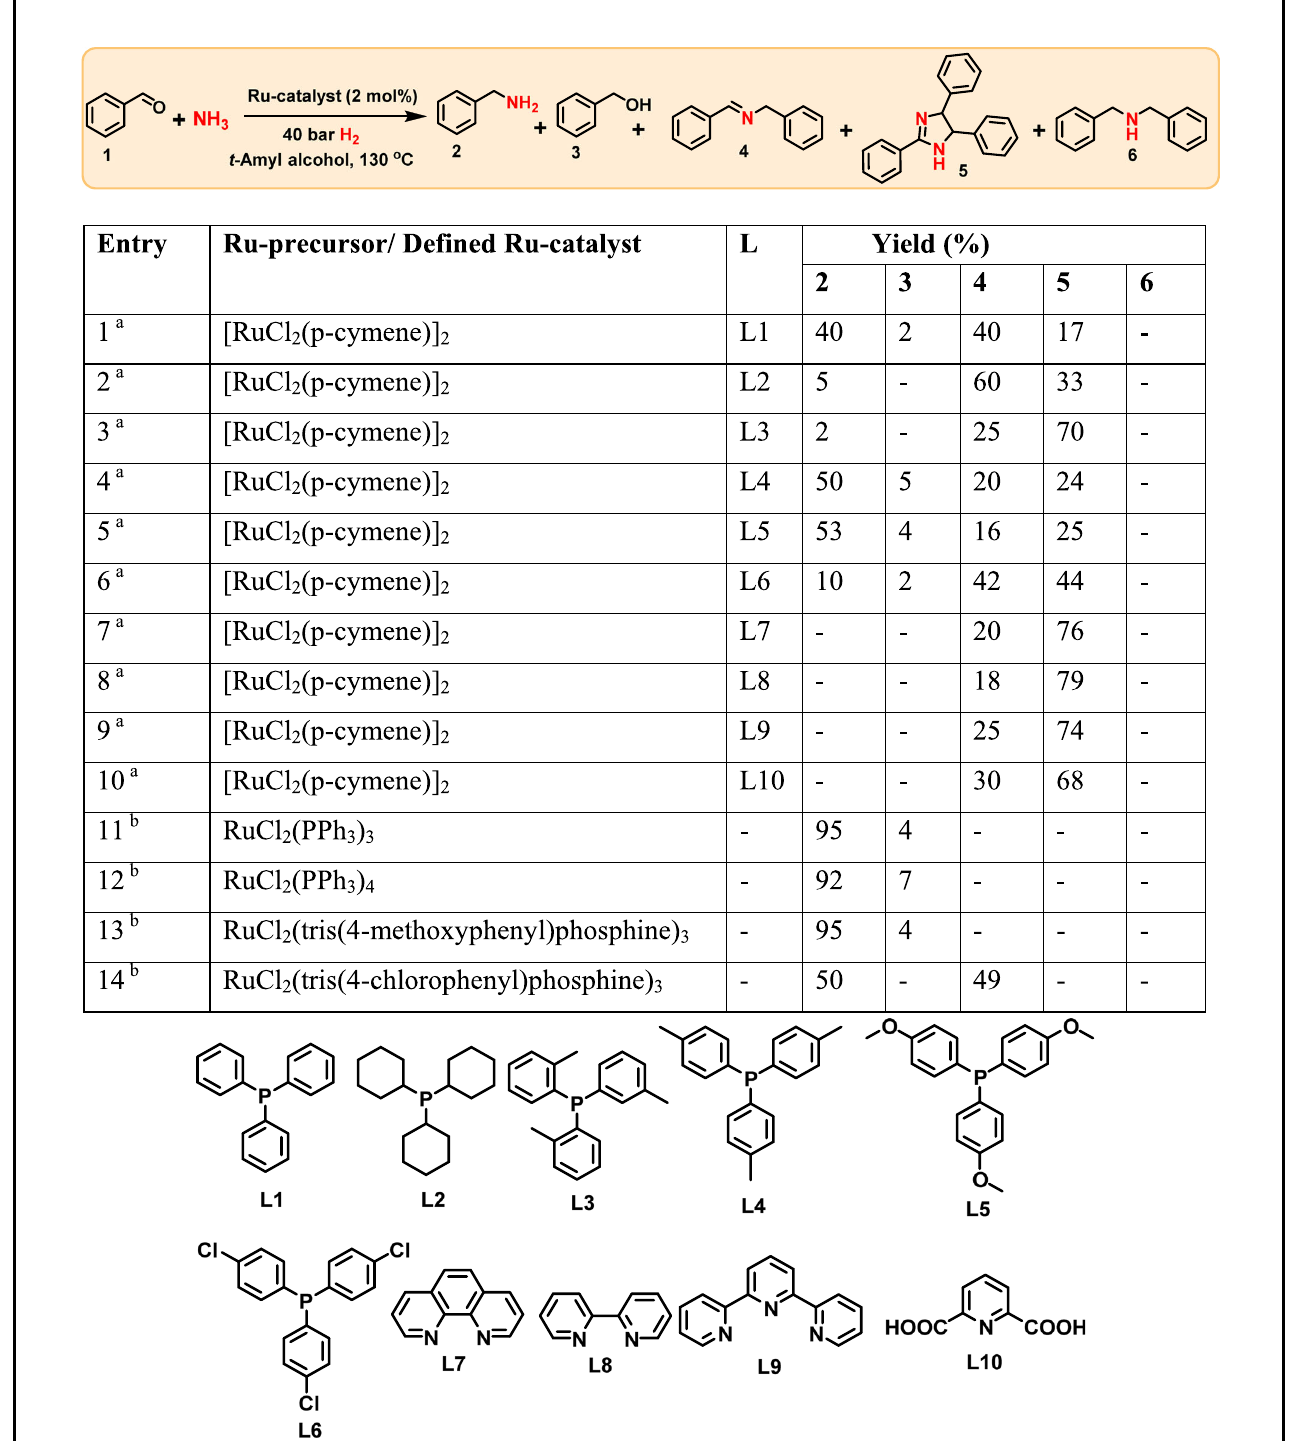
Table 2 Reductive amination of benzaldehyde using ruthenium